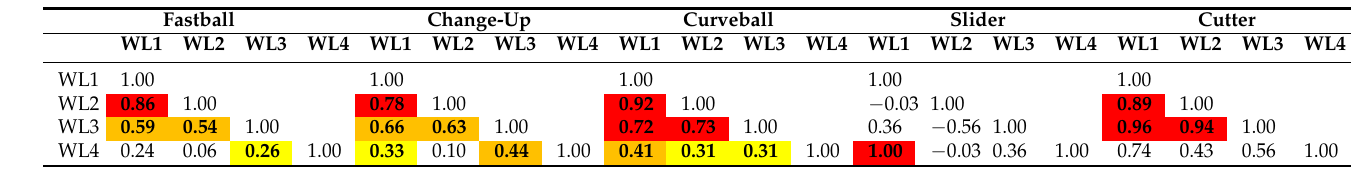
Table 3. Correlation Among Workload Estimates Across Pitch Type. Only forearm sensor location data is used here. WL1 = peak resultant acceleration; WL2 = peak PlayerLoad WL3 = cumulative PlayerLoad; WL4 = normalized resultant acceleration.